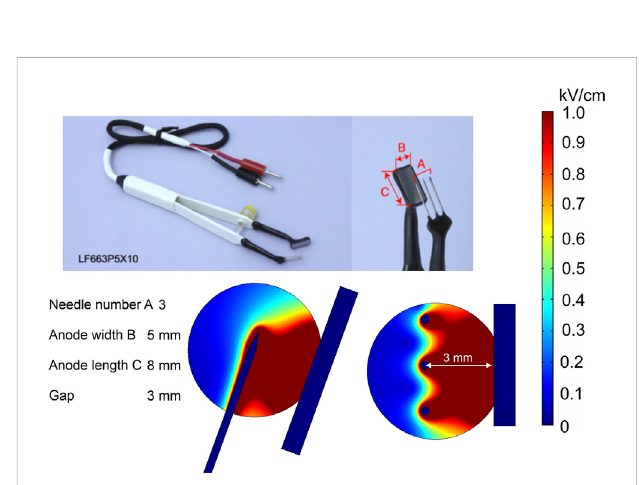
FIGURE 13 Plate-and-fork-type electrodes using 500 V terminal voltage. (A) Commercially available electrodes; (B) electrode structure; (C) spatial electric fi eld distribution, side view; (D) spatial electric fi eld distribution, top